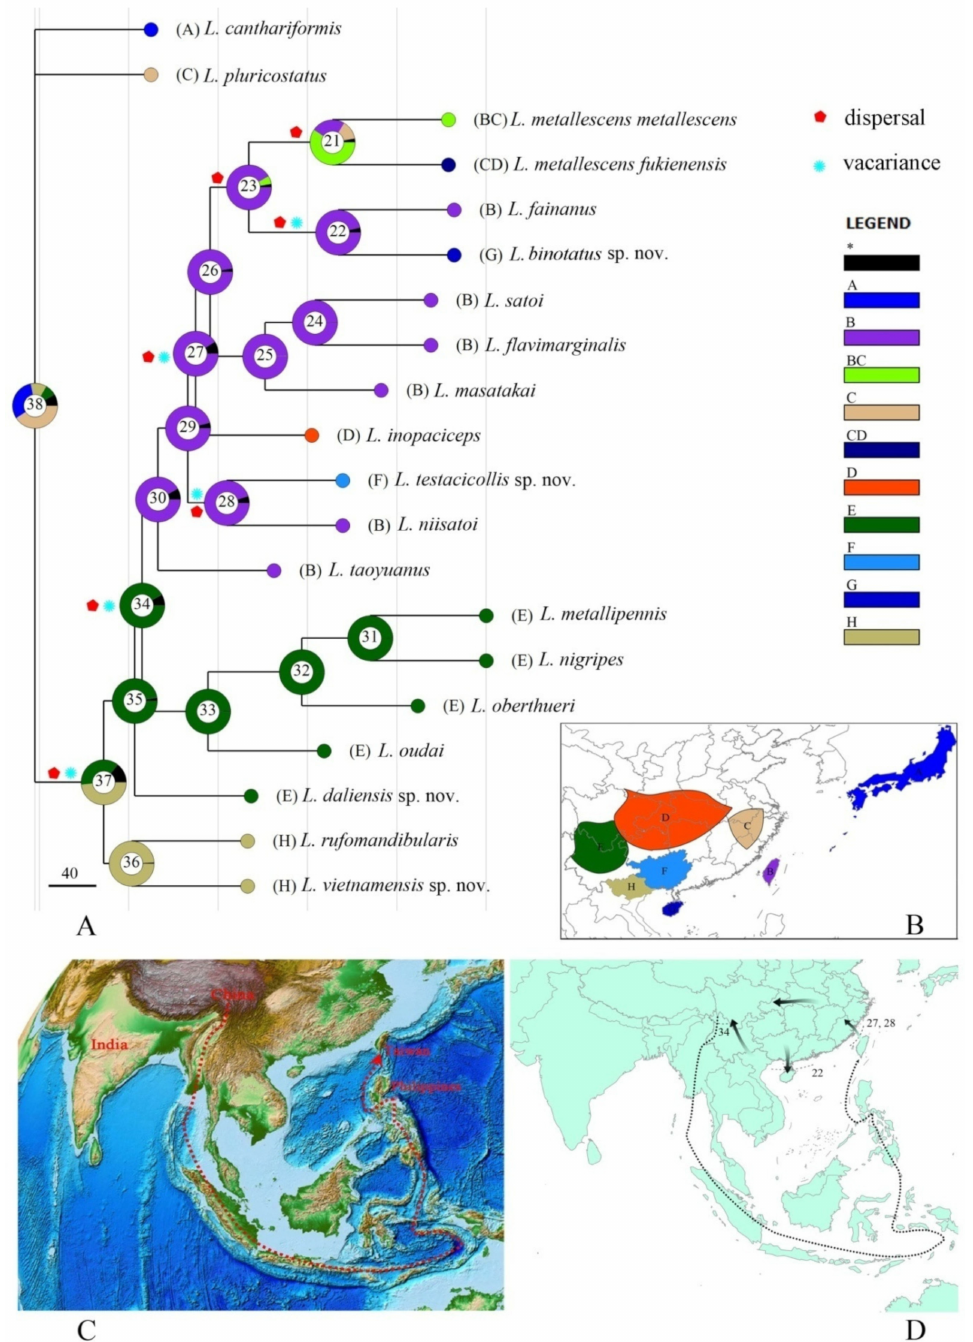
Figure 7. ( A ) Reconstruction of ancestral state in spatial distribution of Lycocerus fainanus species group; ( B ) Biogeographical areas: A: Japan; B: Taiwan; C: southeast China; D: central China; E: southwest China; F: Guangxi; G: Hainan; H: northern Vietnam. ( C ) Drift trajectory of Taiwan (revised from NOAA; derived from Liang, 2013); ( D ) Dispersal routes (indicated by arrows) and vicariance (by dotted lines) events in the biogeographical history of L. fainanus species